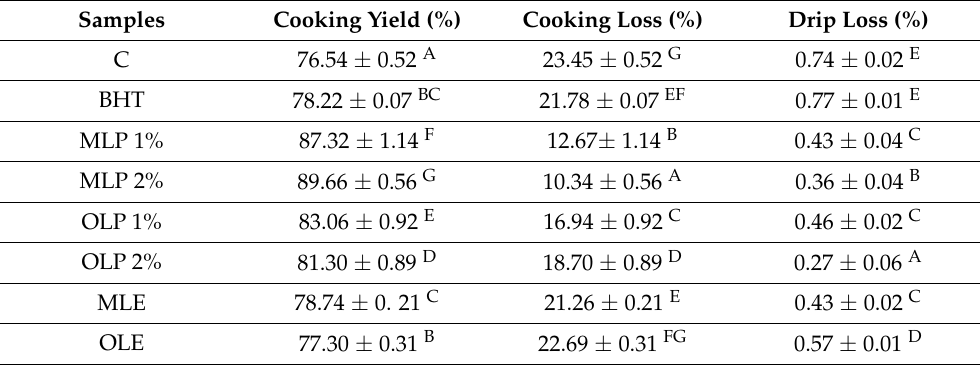
Table 6. Cooking yield, cooking loss, and drip loss percentage of chicken burger